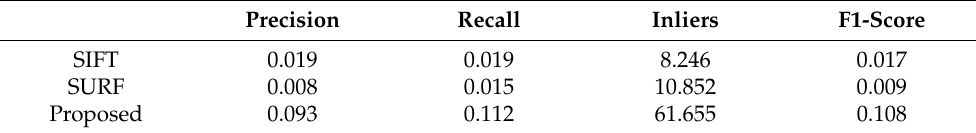
Table 4. Average of the quantitative evaluation indicators in the attitude error experiment. Precision